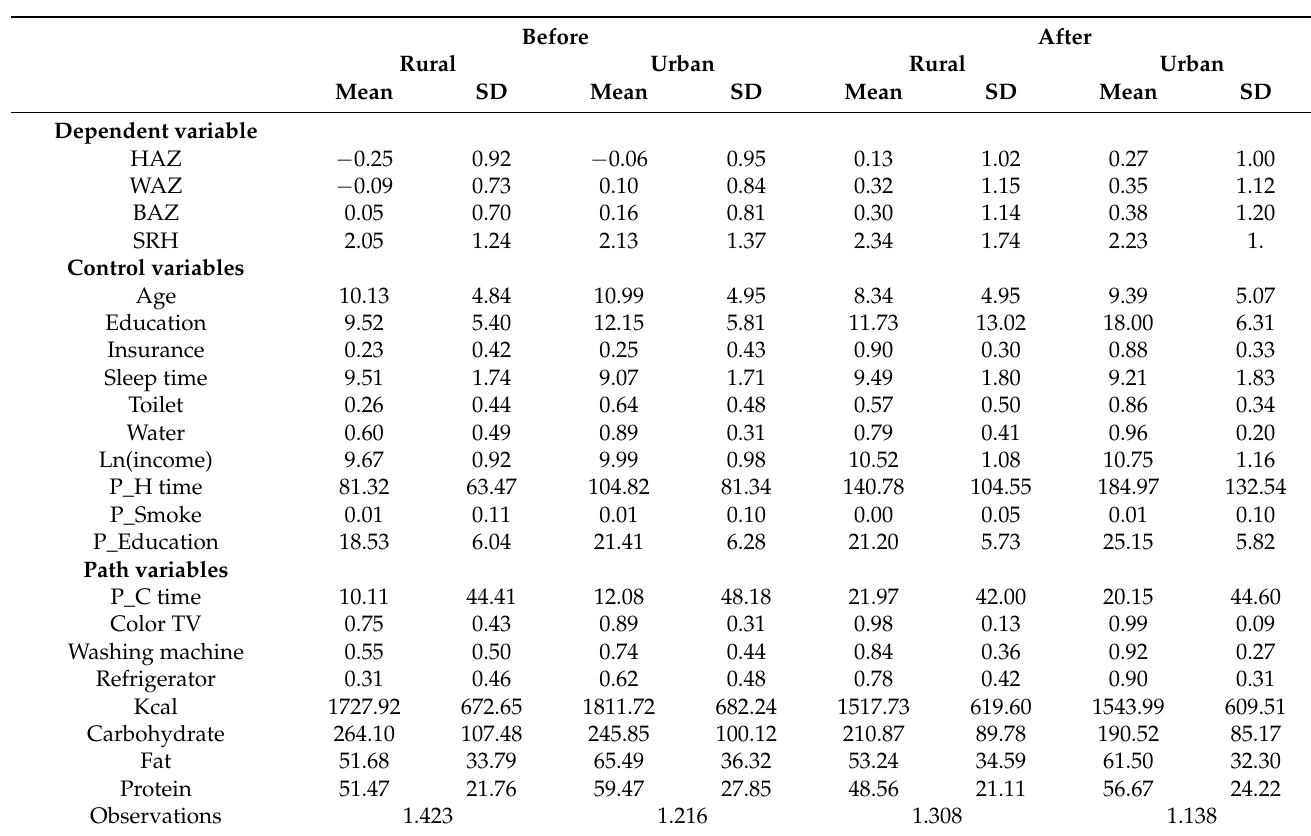
Table 2. Summary of statistics for the crucial